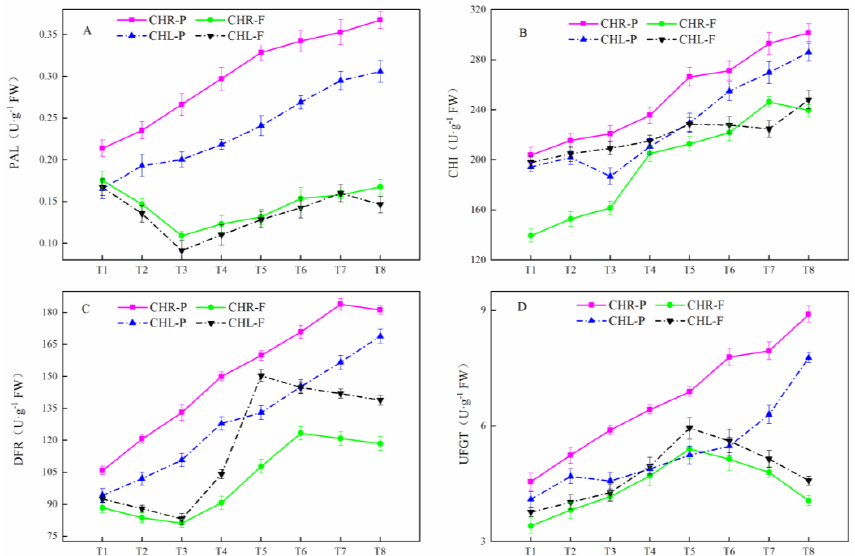
Figure 5. Phenylalanine ammonia − lyase (PAL), chalcone isomerase (CHI), dihydroflavonol − 4 − reductase (DFR), and UDPglucose: flavonoid − 3 − O − glucosyltransferase (UFGT) changes during CHL and CHR ripening. ( A ) PAL; ( B ) CHI; ( C ) DFR; ( D ) UFGT. Each value is the mean for three replicates. The vertical bar indicates the standard error.